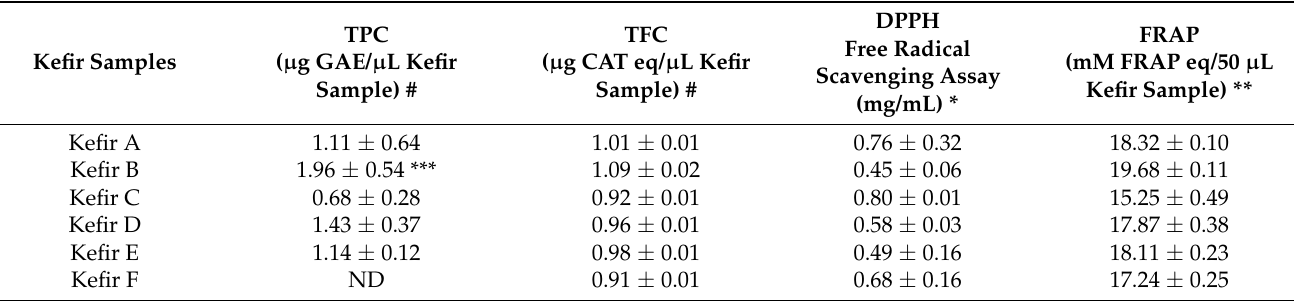
Table 2. Antioxidant assays and the total phenolic and flavonoid content for kefir samples.